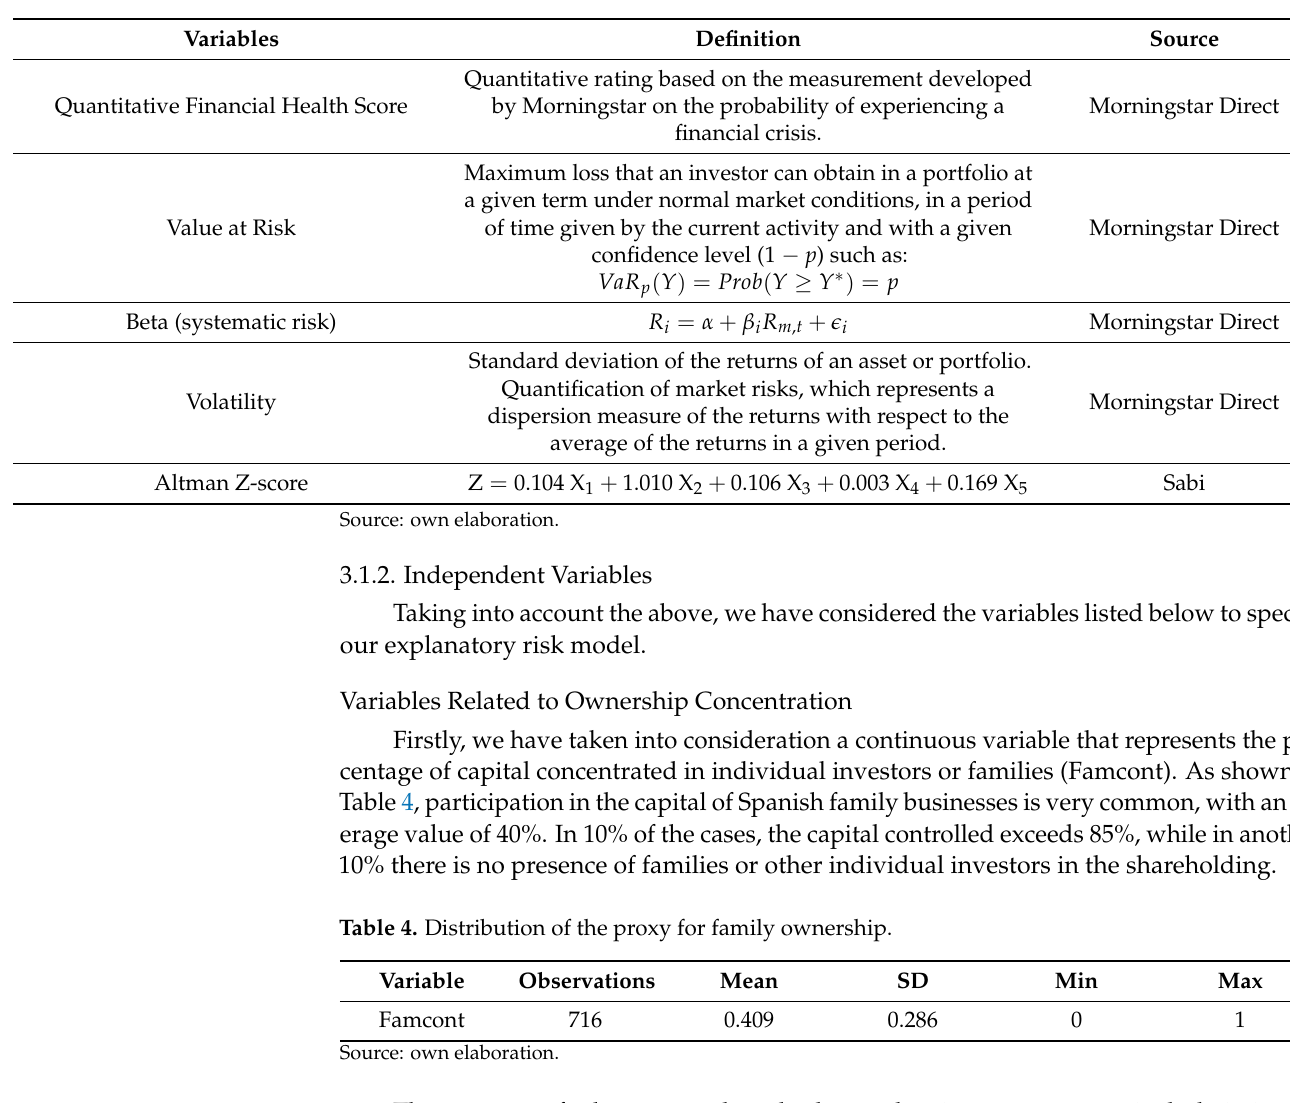
Table 3. Summary of risk-related variables.